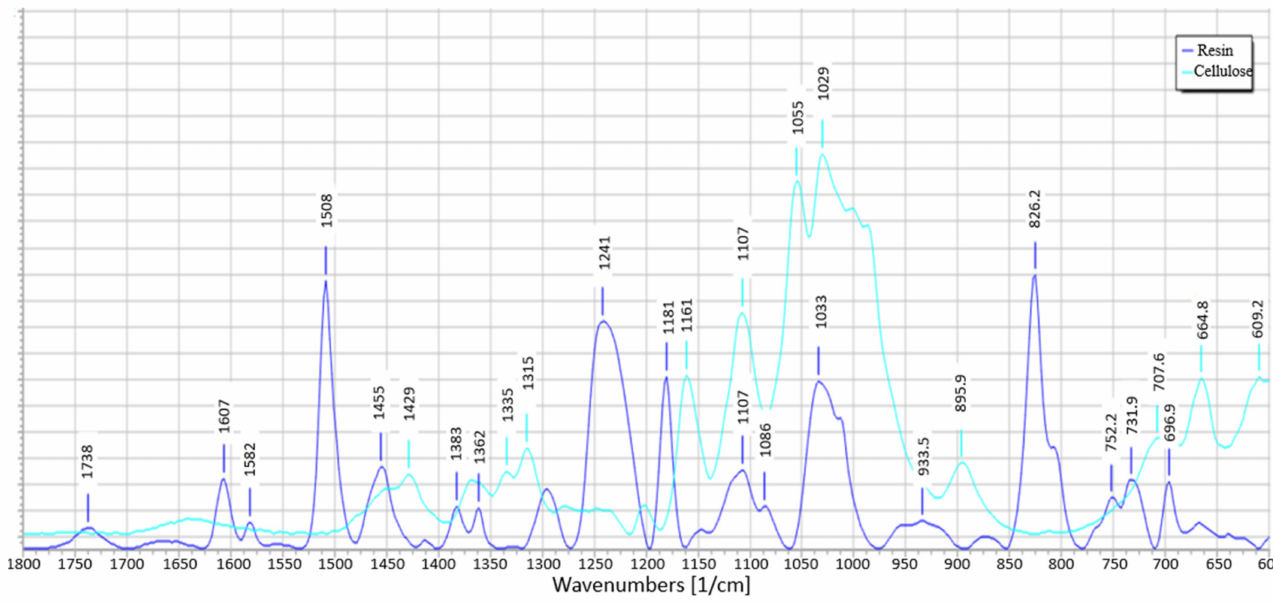
Figure 22. IR spectra for resin and